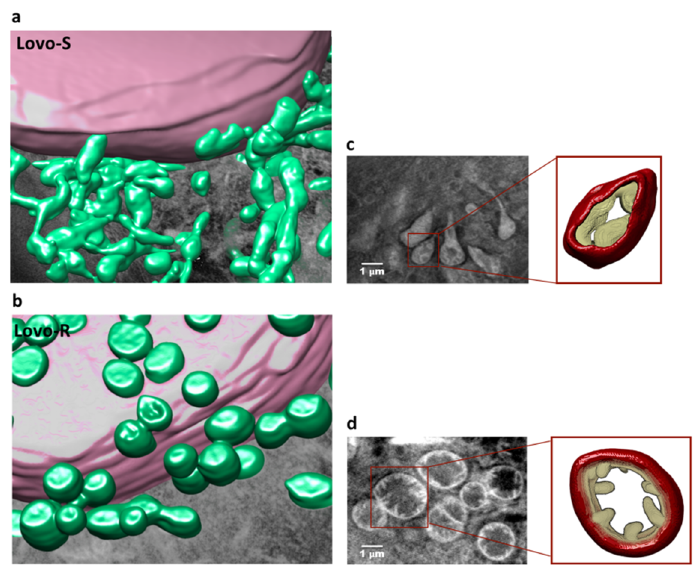
Figure 3. 3D ultrastructural analysis of LoVo-S and LoVo-R mitochondria by synchrotron-based cryo-SXT. Color-coded manual segmentation of the surface boundaries ( a , b ) identifying the nucleus (violet) and mitochondria (green) of three-dimensional reconstruction of whole-cell volumes of LoVo-S and LoVo-R, obtained by cryo-SXT (pixel size 11.8 nm). In ( c ) one slice of the tomogram from the same volume region shown in ( a ) and 3D rendering of a single selected mitochondrion (right panel) of LoVo-S. One slice of the tomogram ( d ) from the same volume region showed in ( b ) and 3D rendering of a single mitochondrion (right panel) of LoVo-R.